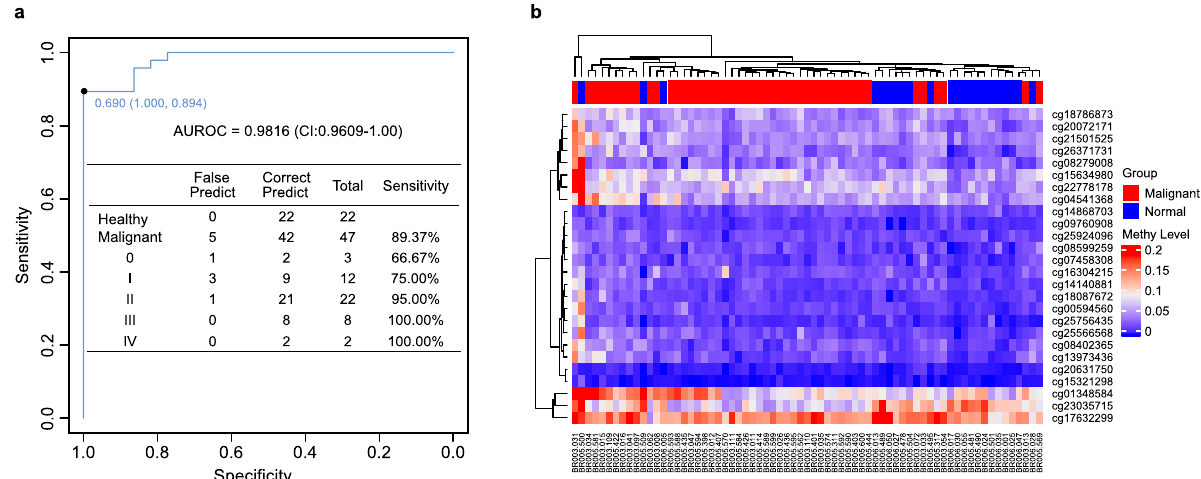
Fig. 2 Performance of the diagnostic model in a validation plasma cohort. a The validation group was composed of 47 breast cancer and 22 normal plasma samples. ROC curve for breast cancer detection using the fi nal model with 26 markers. This model achieved the best diagnostic power with an AUROC of 0.9816 (95% CI: 96.09 – 100%) in the validation dataset. b Heatmap for cfDNA methylation levels of the validation group. Cancer or normal samples could be distinguished through methylation patterns in the validation